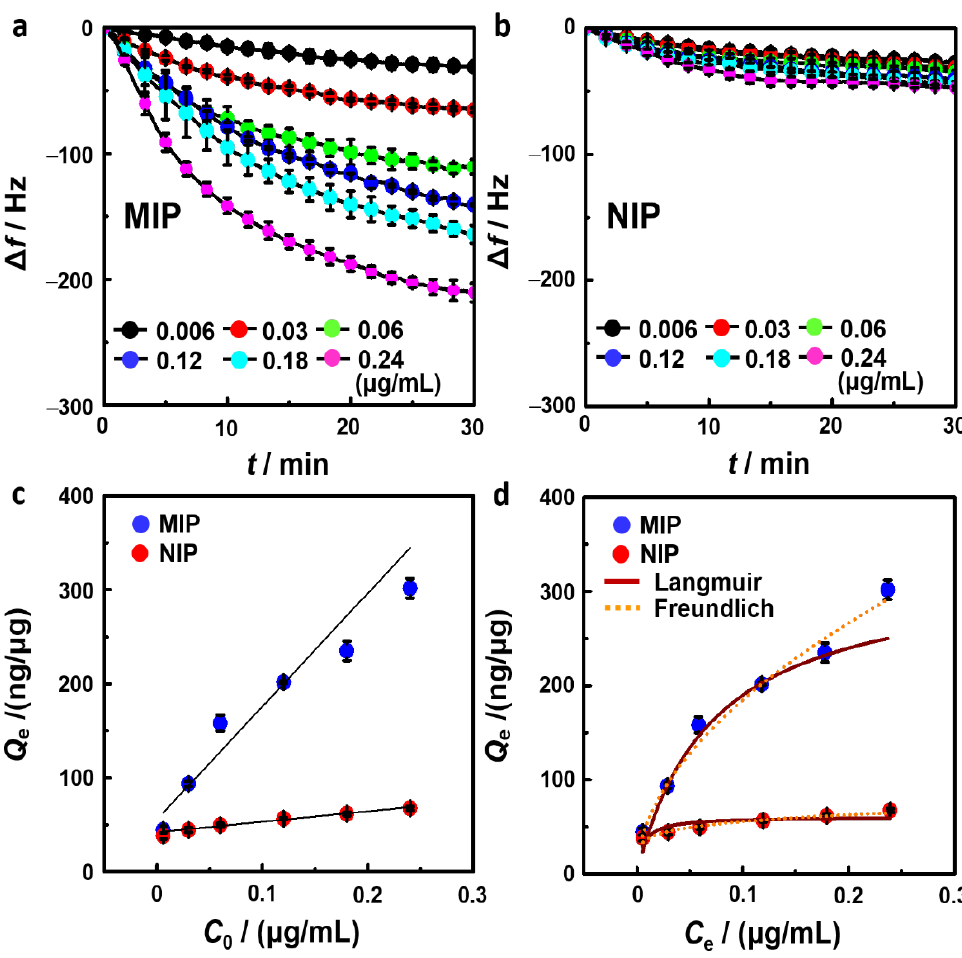
Figure 3. ( a , b ) ∆ f as a function of time for ( a ) MIP and ( b ) NIP film-coated quartz crystal microbalance